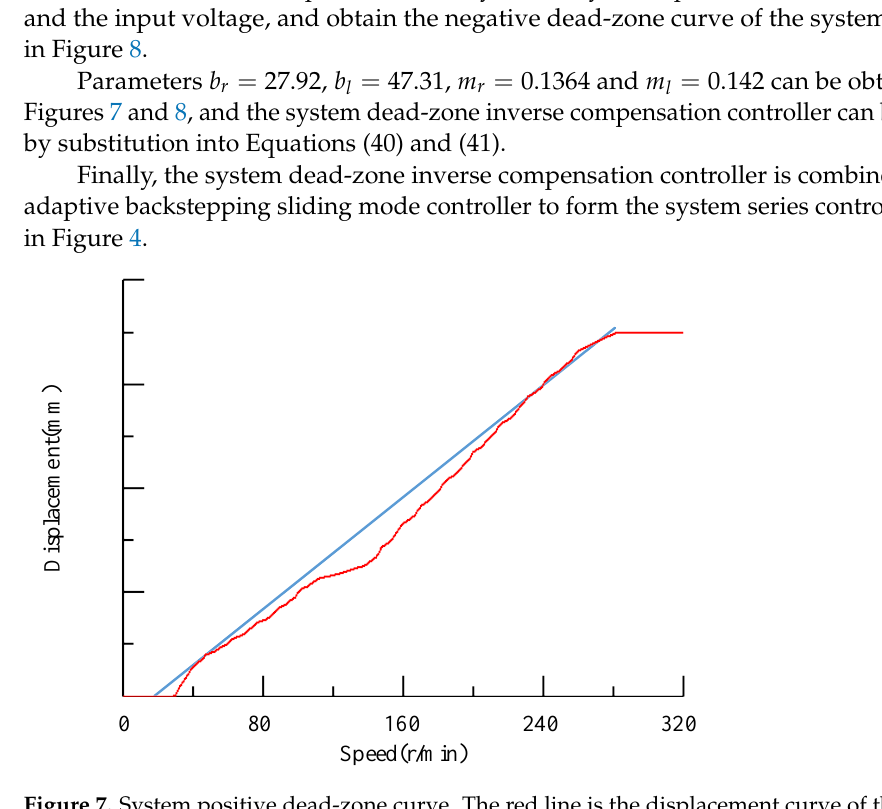
Figure 7. System positive dead-zone curve. The red line is the displacement curve of the hydraulic cylinder in the positive dead-zone of the system, and the blue line is the reference line based on the compensation principle, which is used to obtain the estimated parameters of the dead-zone.